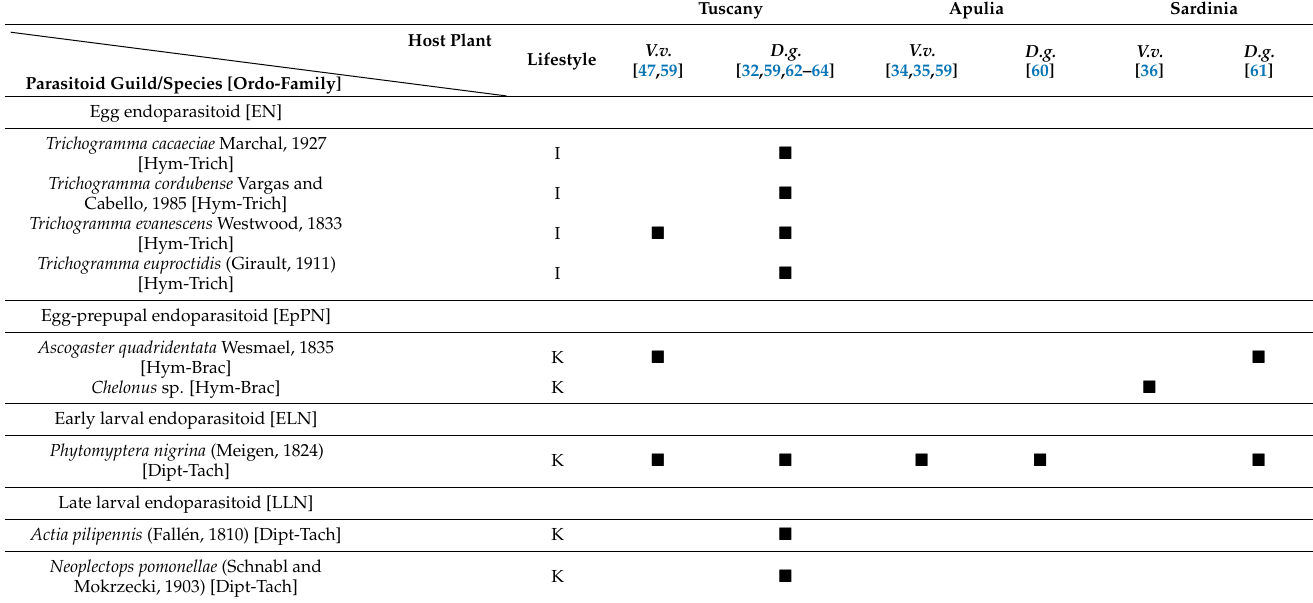
Table 3. Parasitoids of preimaginal stages of the European grapevine moth, Lobesia botrana , found on Daphne gnidium (D.g.) and Vitis vinifera (V.v.) in different Italian regions, based on main previous studies on the topic (references given in square brackets; black squares indicate presence). Species are divided into guilds as proposed by Mills [83]. Lifestyles: I, idiobiont; K, koinobiont; G, gregarious, H, hyperparasitoid; FH, facultative